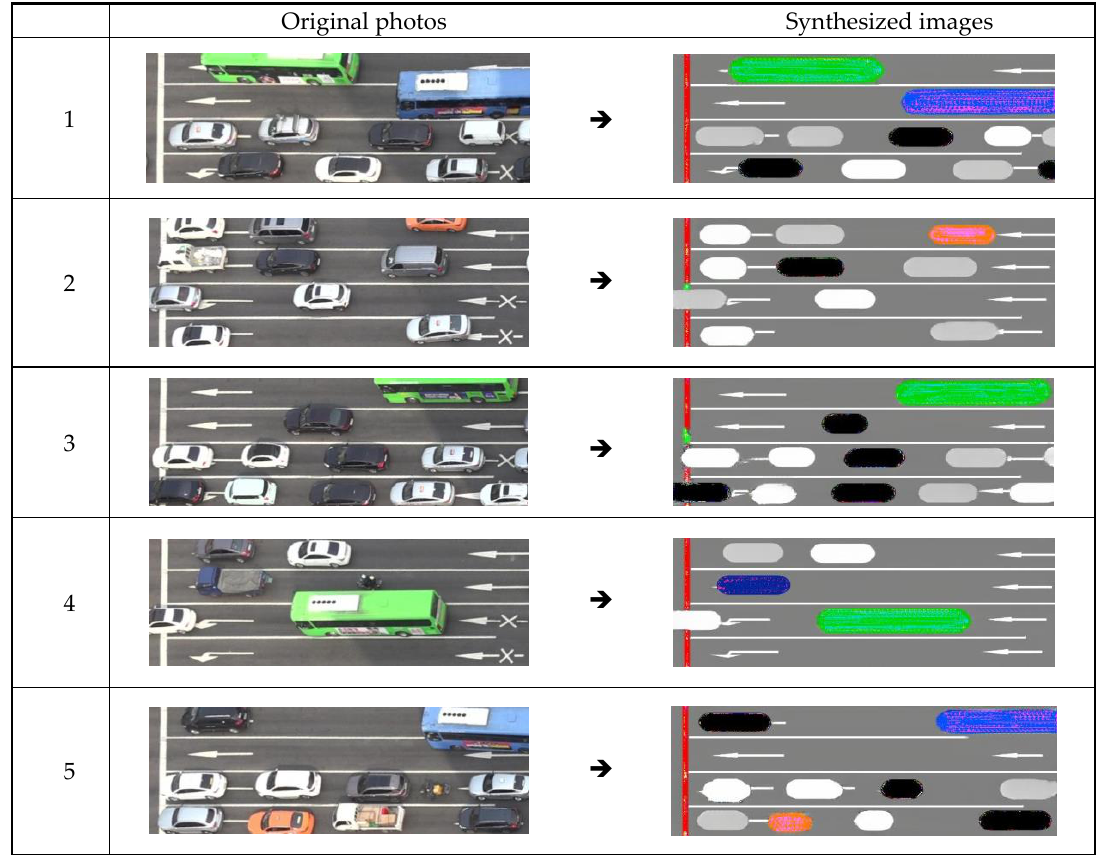
Figure 5. Original photos vs. synthesized images .